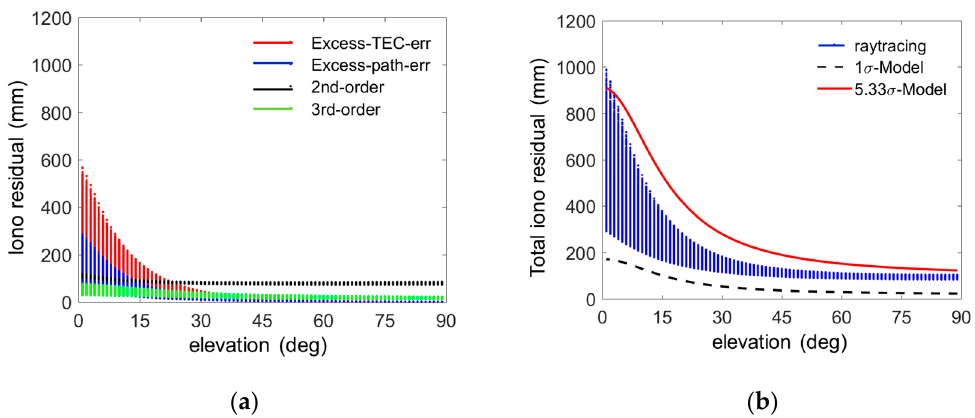
Figure 10. Left panel ( a ) shows ray-tracing estimates of higher-order residuals in the GPS L1–L5 combination. The right panel ( b ) shows the total group delay residuals estimated by the overbounding model and corresponding ray-tracing results.